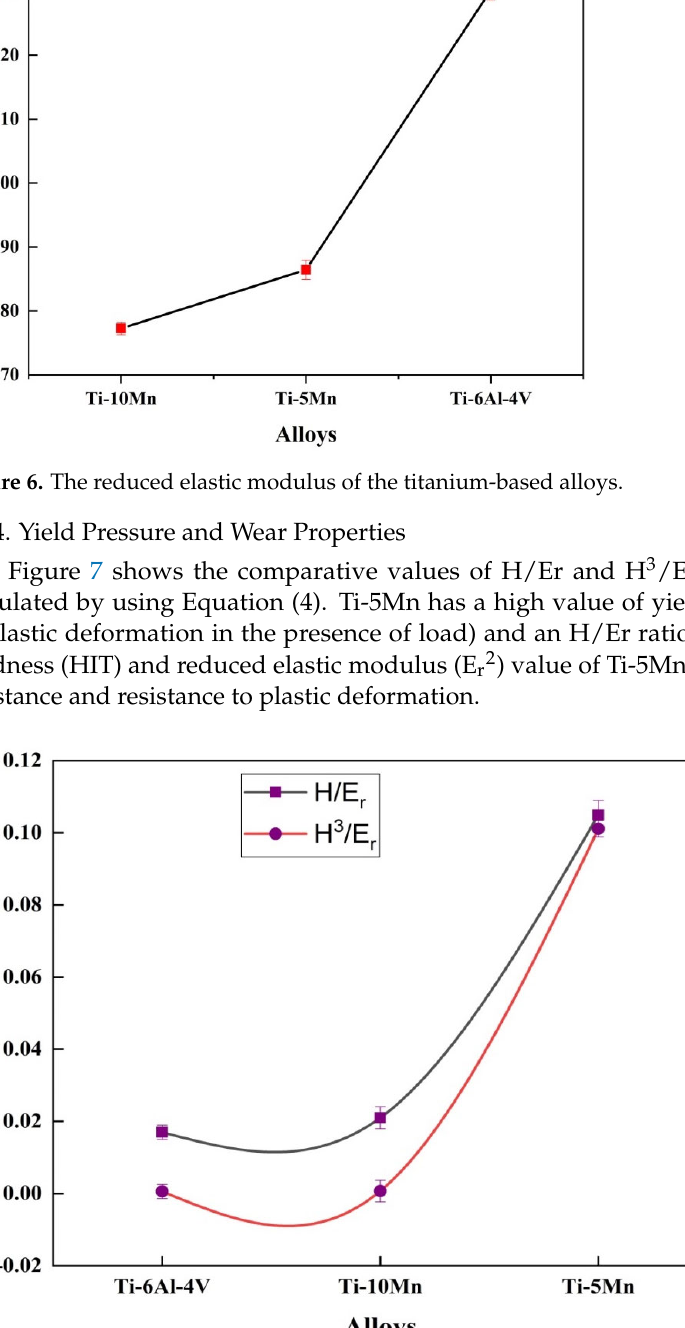
9 of 14 Figure 5. The nanohardness of the titanium ‐ based alloys . Table 2. The hardness values of α and β phases and the bulk sample. S.No.